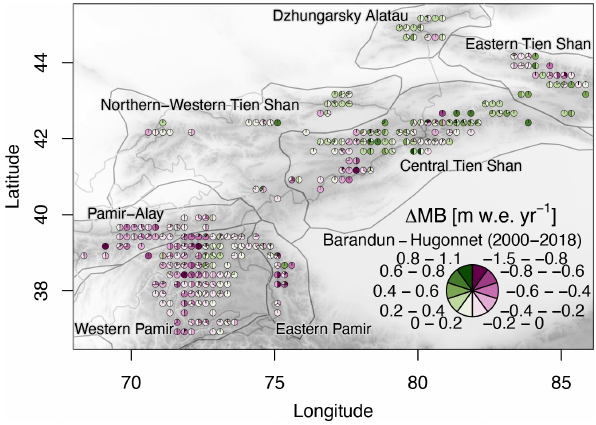
Figure A1. Difference in mean annual glacier mass balance be- tween Barandun et al. (2021a) and Hugonnet et al. (2021) for the period 2000–20018. Estimates from Hugonnet et al. (2021) only include the glaciers for which the transient-snowline-constrained modeling of Barandun et al. (2021a) provides estimates. The pie charts aggregate values per glacier into classes and the relative class frequencies. Pie charts are not scaled to glacier